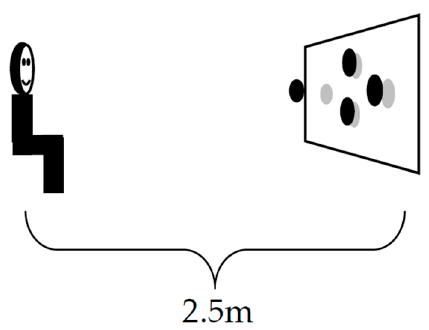
Figure 1. Schematic drawing of the experiment setup: Test person sits centrally in front of the screen looking at the centre of the screen. The distance between participants and test screen was 2.5 m. All tests were presented on the same polarized 3D-TV with 4K (Philips 32PFL5008K/81ck, 32 Zoll, Full HD, 3D with a resolution of 3840 × 2160 dpi).